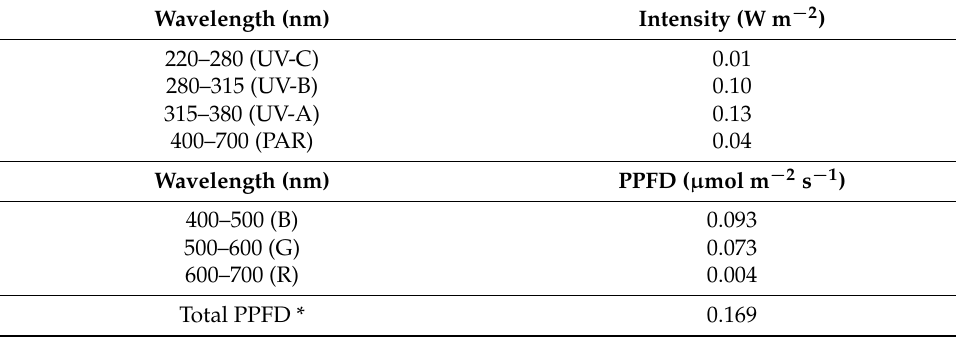
Table 5. Spectral characteristic of the UV-B lamp. (UV-B intensity set at 0.1 W m − 2